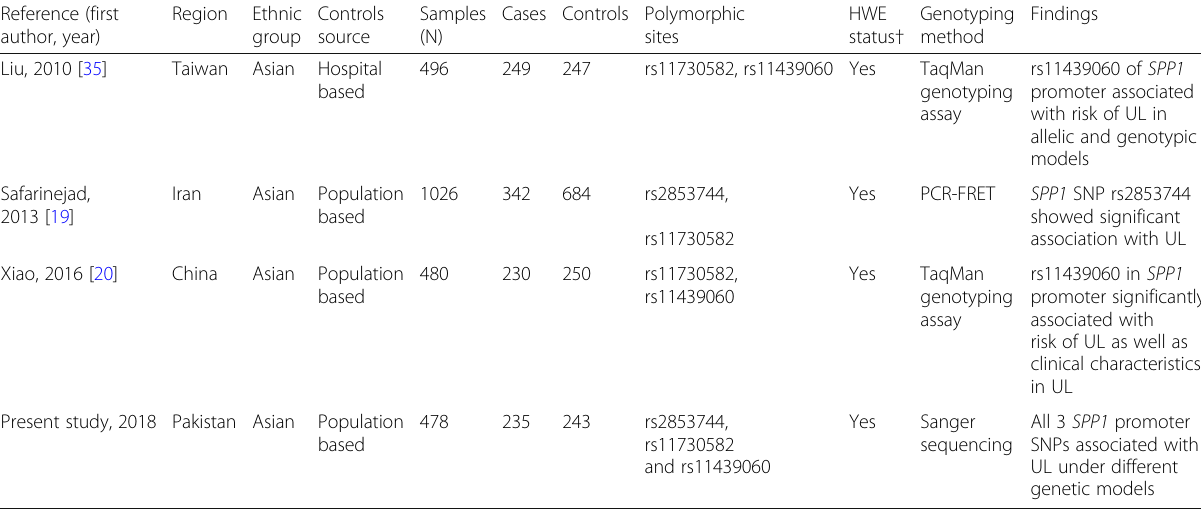
Table 4 Main characteristics and findings of the eligible studies included in this